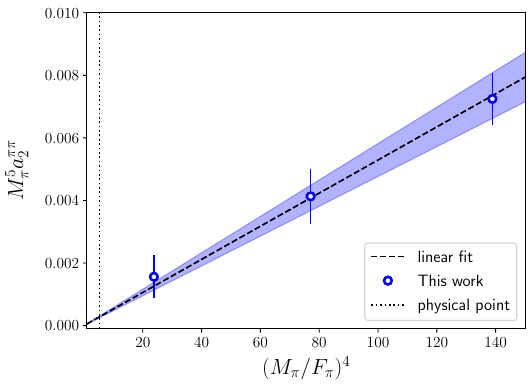
Figure 7. Dependence of the d -wave scattering length on ( M π /F π ) 4 . We include a linear fit based on chiral expectations, and indicate the position of the physical